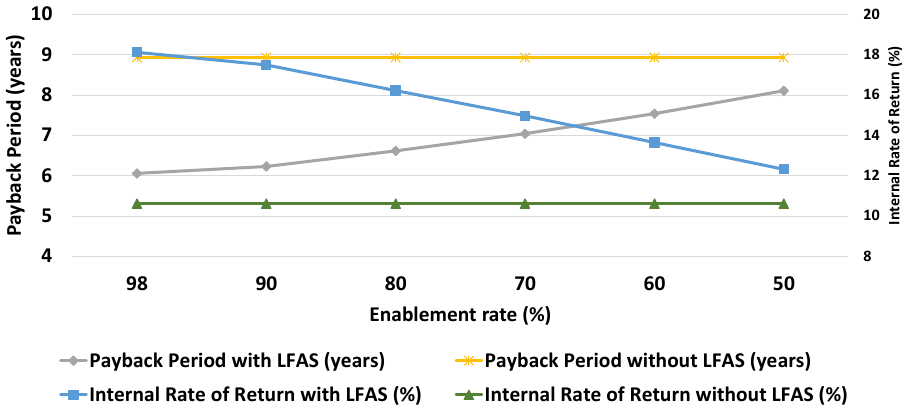
Figure 5. The payback periods and internal rates of return for different levels of enablement rate (%) for the LFAS market and without the LFAS market.